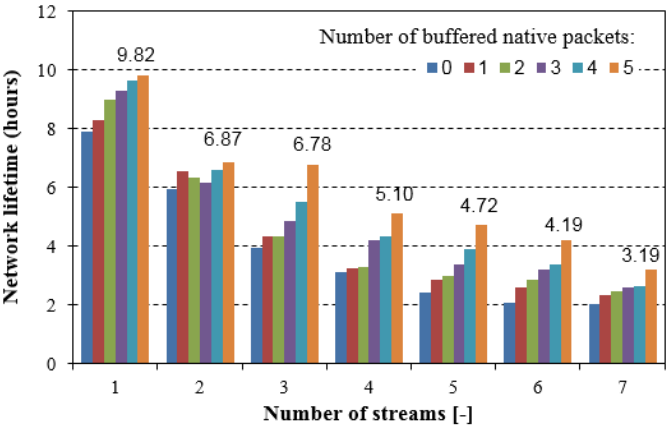
Figure 14. Estimated network lifetime (extended testing scenario).